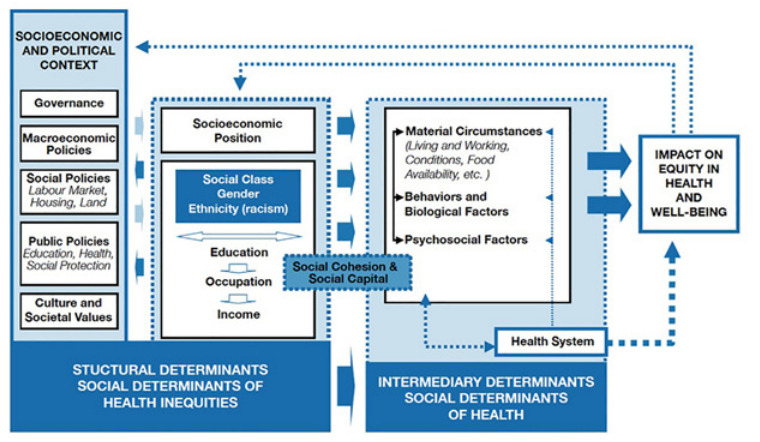
Fig 1. WHO Social Determinants of Health